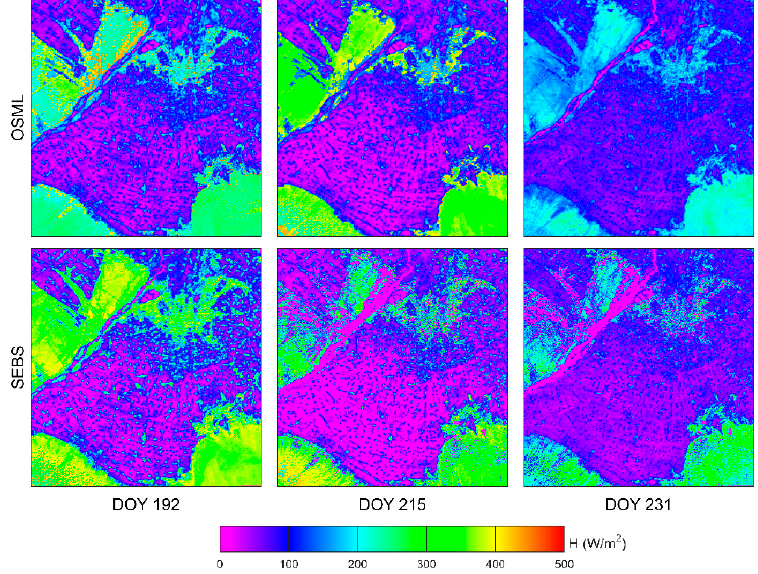
Figure 13. The spatial distribution of H over MUSOEXE site based on OSML and SEBS from satellite-based variables at satellite overpass time on DOY 192, DOY 215 and DOY 231 of 2012.